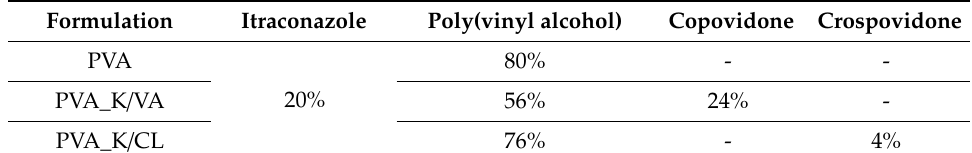
Table 1. Composition of the filaments.